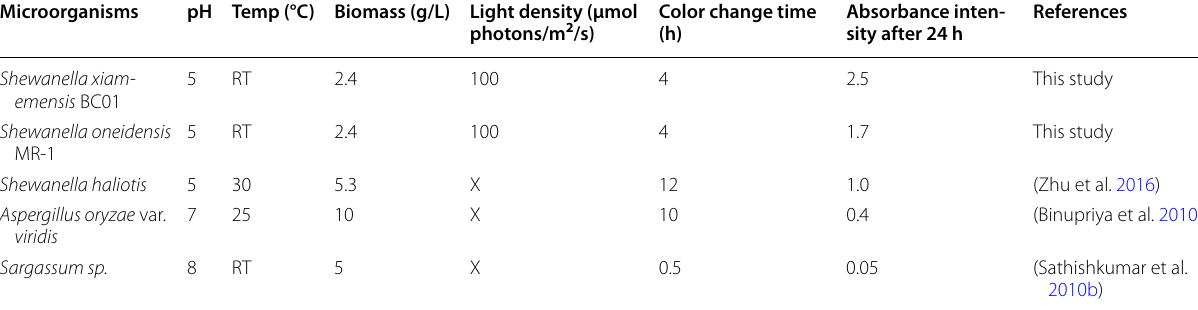
RT room temperature